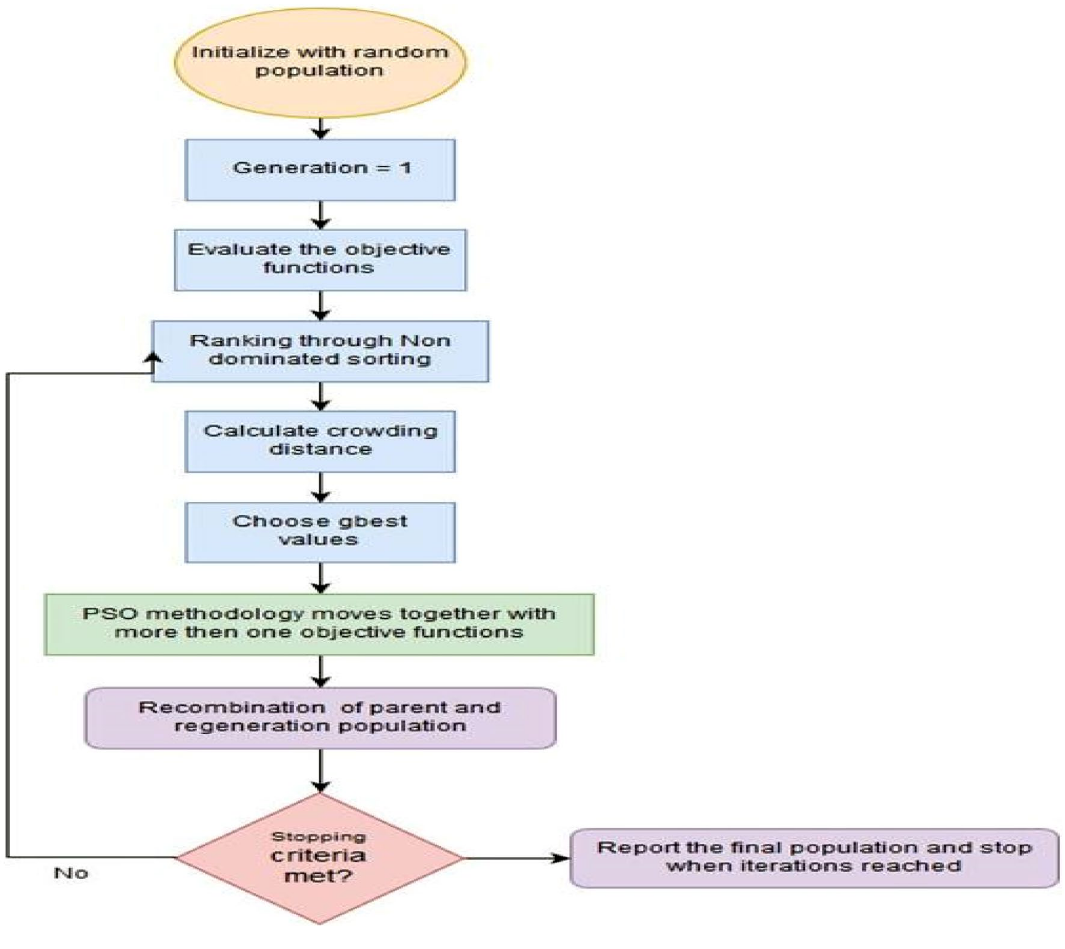
Figure 15. Flow chart of MOPSO.